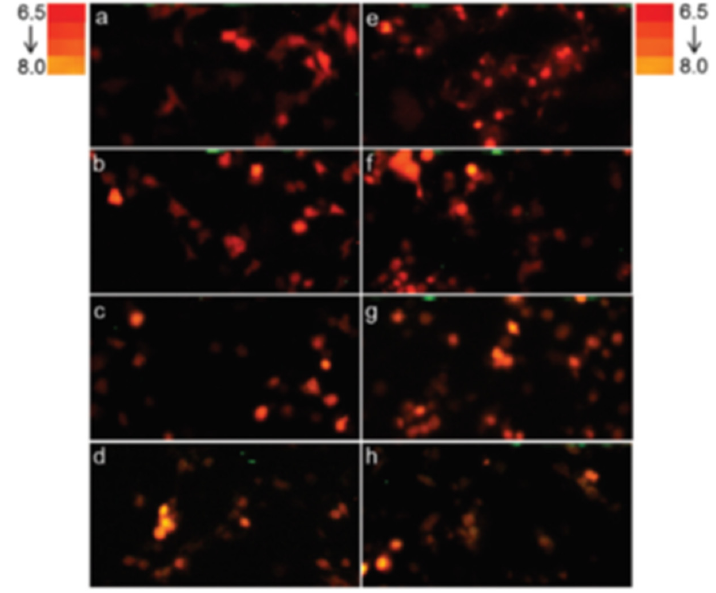
Figure 8. Firefly luciferase color reporting of intracellular pH change in mammalian cells. In vivo bioluminescence color change of COS-1 cells transfected with pCMV-Mac expressing Macrolampis firefly luciferase at different pH in calibration buffer containing nigericin. Reprinted with permission from ref. [34]. Copyright 2019 Royal Society of Chemistry. (left panels: a – d ) luciferase directed to cytoplasm; (right panel: e – h ) luciferase directed to nucleus; ( a , e ) pH 6.5; ( b , f ) pH 7.0; ( c , g ) pH 7.5; and ( d , h ) pH 8.0. The reddish bioluminescence indicates acidic pH, whereas the orange-yellow indicates more alkaline pH.